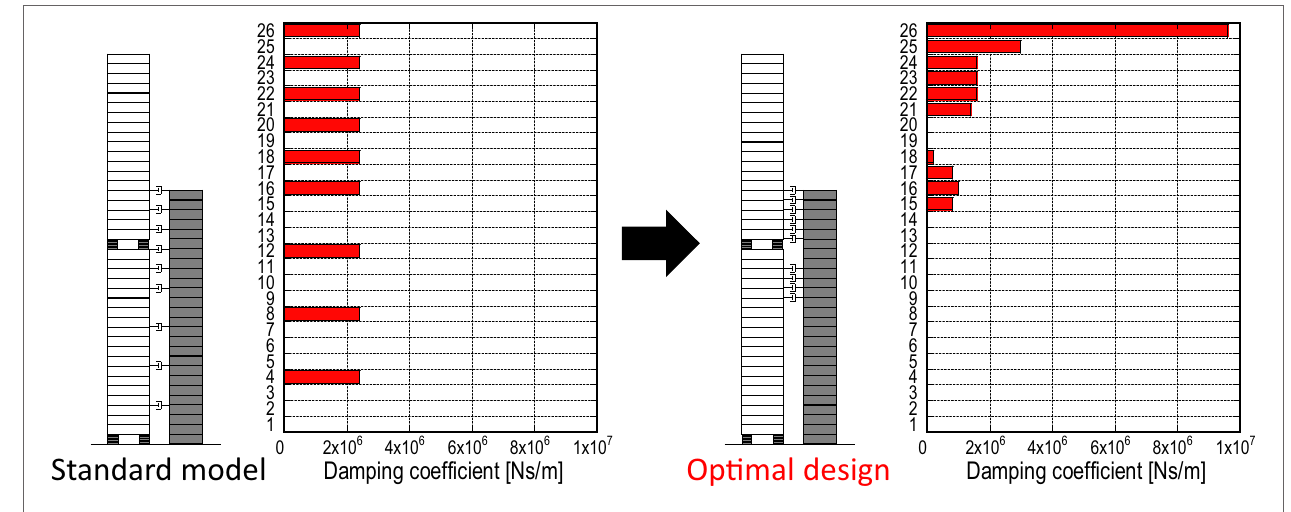
FIGURE 13 | Optimal location of connection damper .